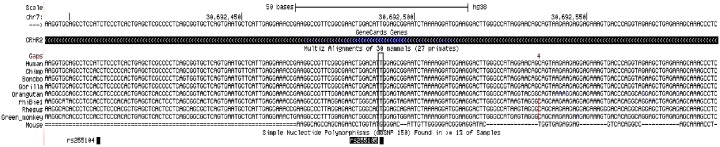
Evolutionary conservation of SNP rs255015 region.The ancestral T allele is highly conserved across representative species.